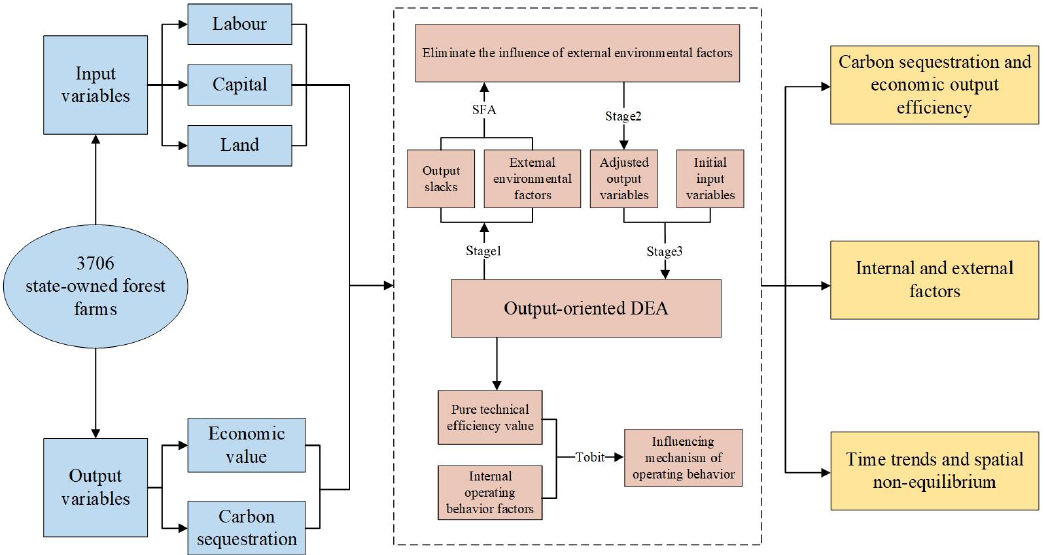
Figure 1. A model system of carbon sequestration output performance of state-owned forest farms.